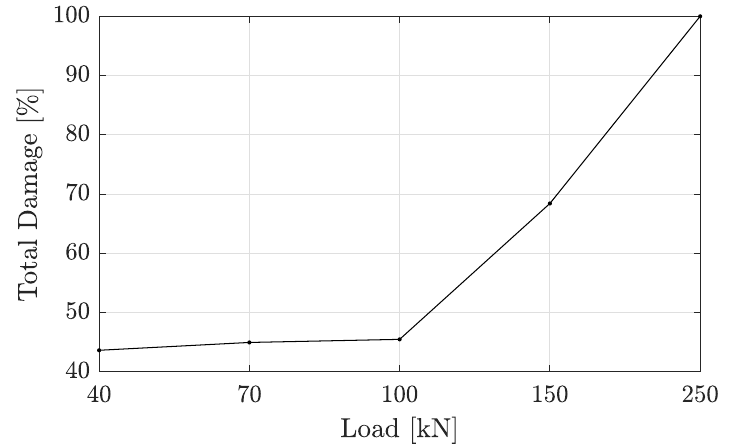
Figure 13. Increase in damage